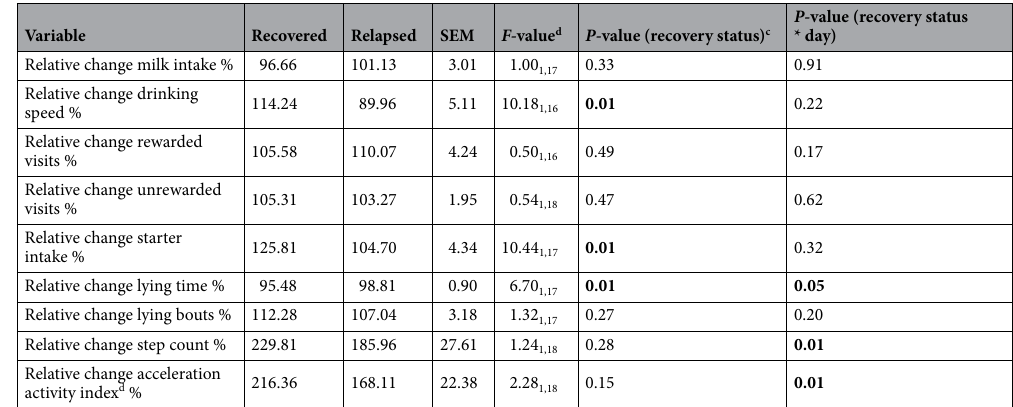
Table 2. Association of recovery status (recovered or relapsed) with relative changes in feeding and activity behaviors of dairy calves (n = 19 matched pairs a ) in the 10 days after initial Bovine Respiratory Disease diagnosis and antimicrobial therapy on d 0. Relative changes referred to day 0 as a baseline. Feeding behaviors (average drinking speed, milk intake, and number of rewarded visits) were recorded by an automated milk feeder from calves offered 10 L of milk replacer/day, and activity measures (lying time, step count, acceleration activity index b and lying bouts) were recorded by a pedometer. Results are reported as least squares means c . a All calves were pair matched to healthy calves by age at diagnosis, birthdate, and gender. Bovine Respiratory Disease was defined as a clinical score of at least 5 26 and lobar lung consolidation 27 . b The acceleration activity index was generated by the commercial software algorithm (IceRobotics, Scotland) based on a calf’s daily average acceleration rate and step count. c Significance are in bold P < 0.05. d Superscripts refer to numerator and denominator degrees of